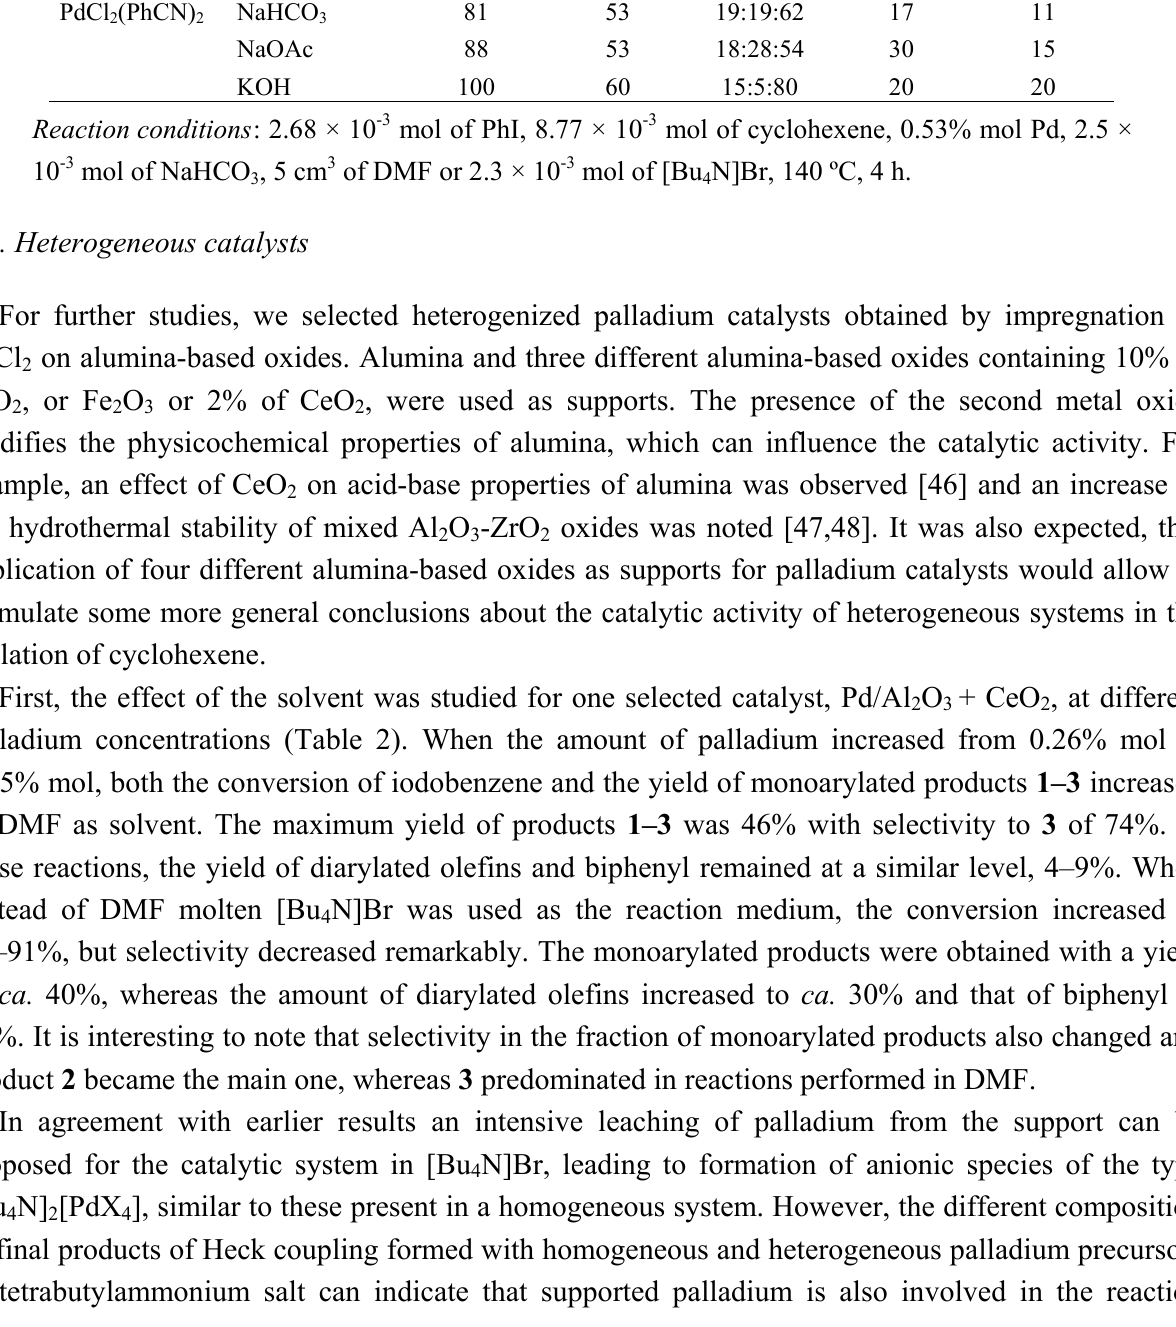
Table 1. Results of the Heck coupling of iodobenzene with cyclohexene catalyzed by and PdCl (PhCN) in [Bu N]Br. Pd(OAc) 2 2 2 4 PhI Yield Selectivity Yield Biphenyl Catalyst Base conversion 1+2+3 1:2:3 4+5+6+7+8 (%) (%) (%) (%) Pd(OAc) NaHCO 74 55 16:20:64 16 4 2 3 NaOAc 90 53 17:21:62 27 KOH 100 67 13:3:84 23 10 PdCl (PhCN) NaHCO 81 53 19:19:62 17 11 2 2 3 NaOAc 88 53 18:28:54 30 15 KOH 100 60 15:5:80 20 20 Reaction conditions : 2.68 × 10 -3 mol of PhI, 8.77 × 10 -3 mol of cyclohexene, 0.53% mol Pd, 2.5 × 10 -3 mol of NaHCO , 5 cm 3 of DMF or 2.3 × 10 -3 mol of [Bu N]Br, 140 ºC, 4 3 4